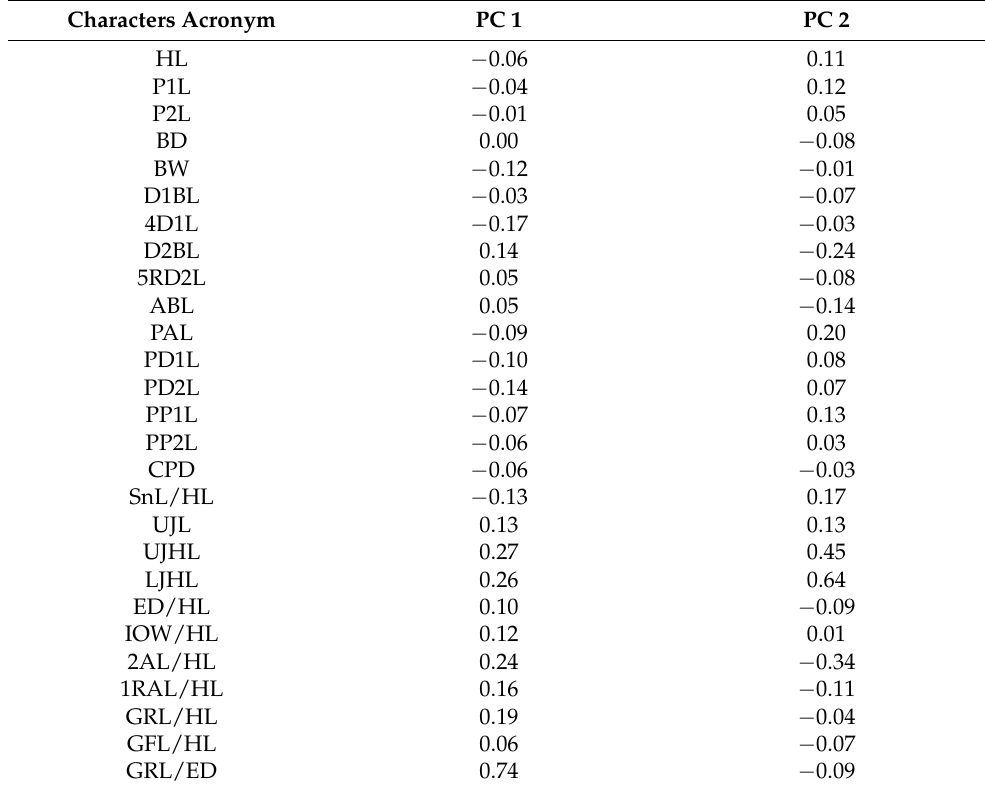
Table 4. Morphological character factor loadings (correlations between variables and PC axes) for PC1 and PC2 within the genus Johnius . Character acronyms and definitions are explained in Table